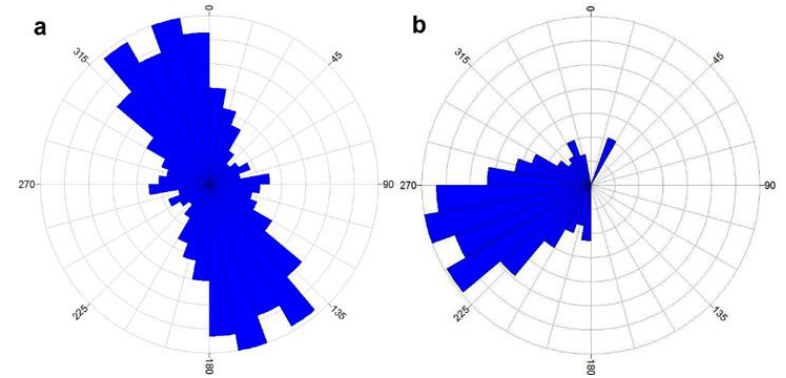
Figure 4. ( a ) Dykes trend in Sungun copper deposit (N = 752); ( b ) Dip of dykes in Sungun copper deposit.